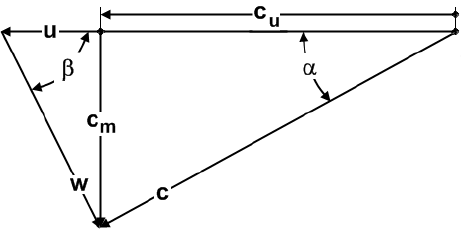
Figure 9. Velocity triangle.